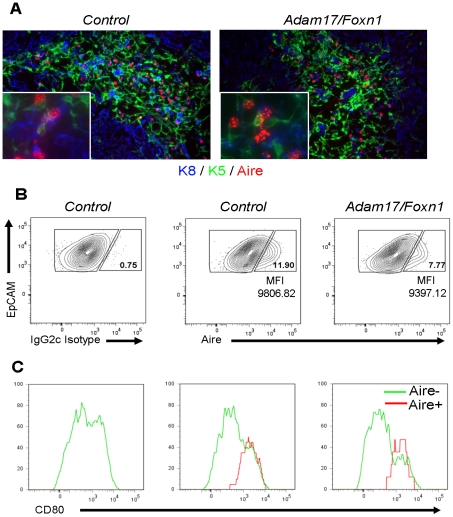
Adam17/Foxn1 mice display normal cortico-medullary thymic architecture.(A) Representative thymic sections from 8-week old mice stained for Keratin-5 (K8), Keratin-8 (K8), and Aire. Inset displays a higher magnification image demonstrating the typical speckled nuclear Aire staining [59] that is present in both Control and Adam17/Foxn1 thymi. (B) Thymi from 11-week old mice were pooled and digested and CD45-Ter119-EpCAM+ TECs were analyzed for Aire expression (n≥3 for each pool). Aire+ gates were determined on the basis of IgG2c isotype control staining. (C) CD80 levels were determined for Aire+ and Aire- TECs based on gating in Part B. MFI, mean fluorescence intensity. Control: fl/+ or fl/fl; Adam17/Foxn1: Cre fl/fl.